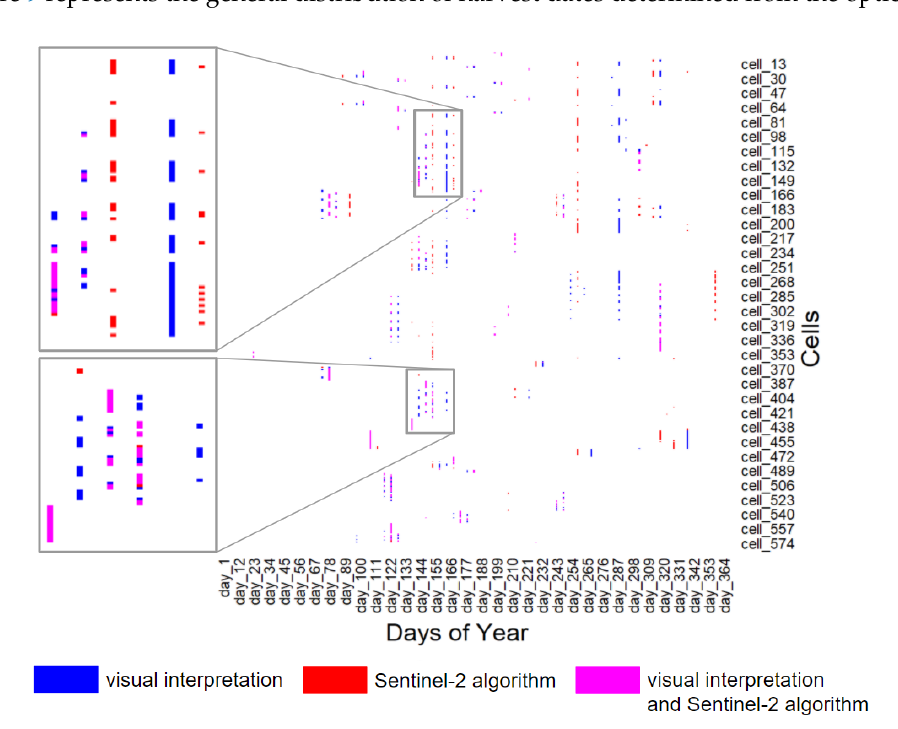
Figure 9. Harvest dates: (1) identified by visual interpretation; (2) determined by the algorithm from the optical data; (3) coinciding harvest dates determined by the two mentioned